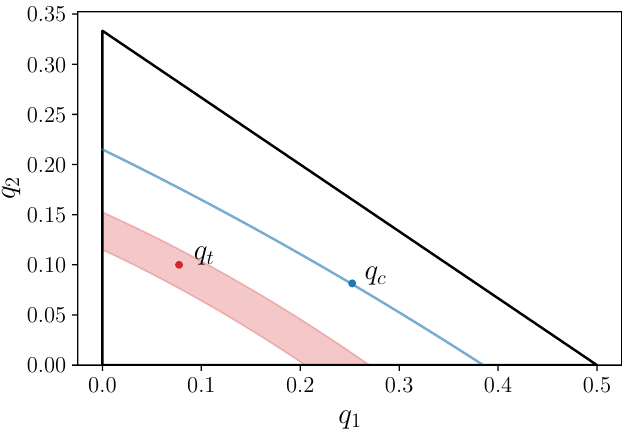
Figure 3. A Weyl chamber for G 2 showing the coordinates for states with vanishing fundamental Polyakov loop (blue line) and for states with Polyakov loop in the range 0 . 38 . l ( q t ) . 0 . 55 , corresponding to the expected region right above the critical temperature (red area). The two points show examples of randomly drawn states q c and q t